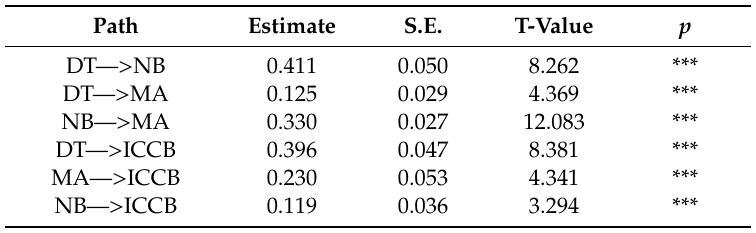
Table 3. The test of direct e ff ect ( N =